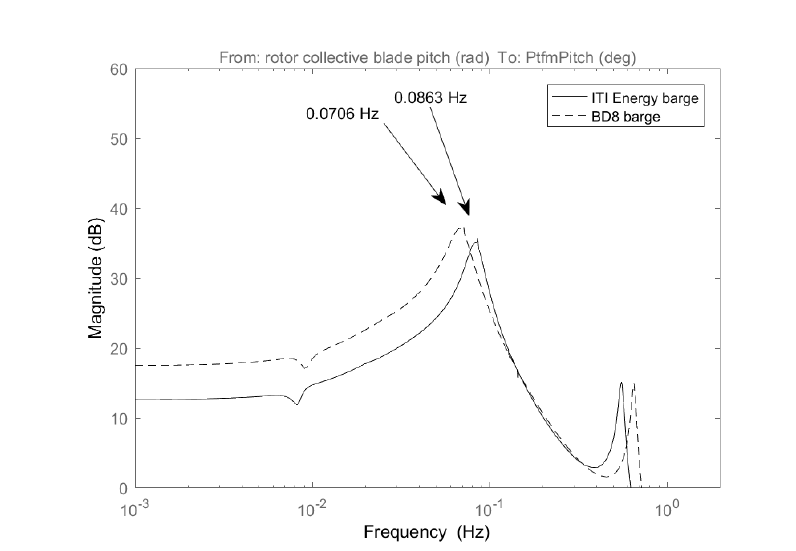
Figure 3. Collective blade-pitch to platform-pitch open loop bode diagrams.